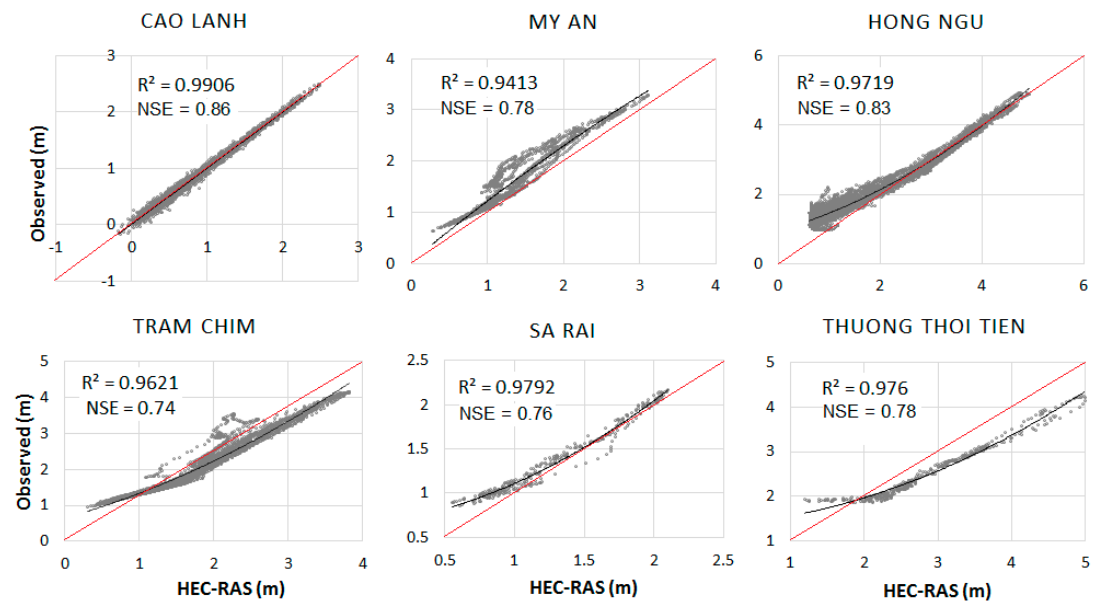
Figure 8. Results of calibration and validation for the HEC-RAS 2D Dong Thap model.